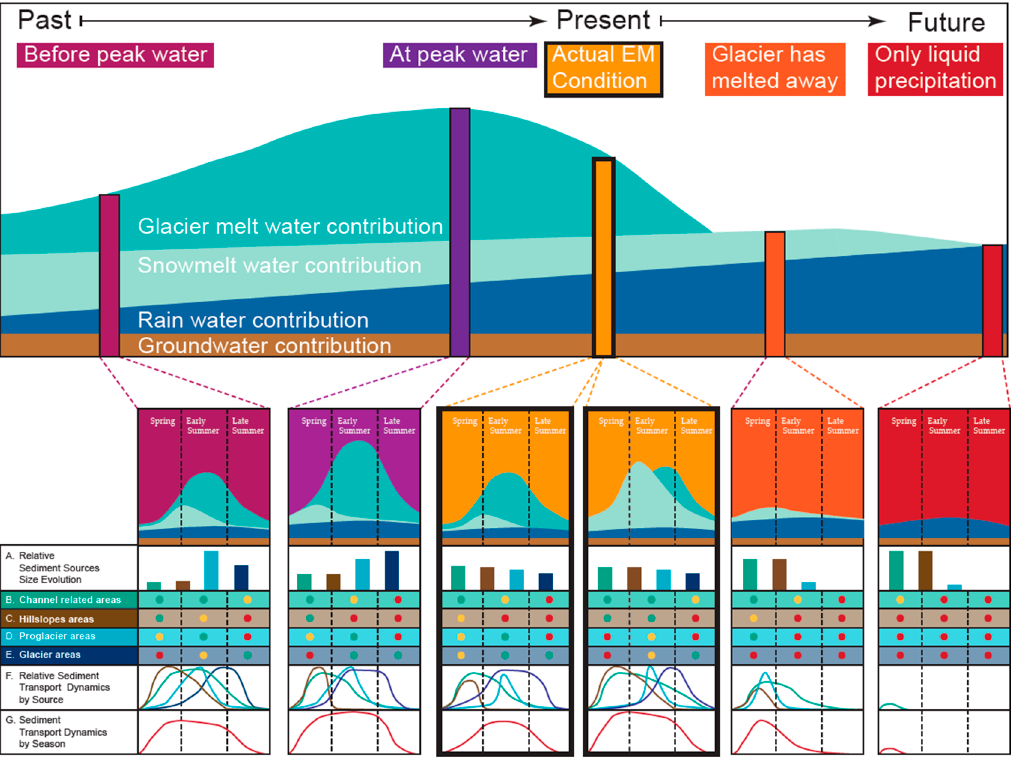
Figure 15. Conceptual representation of the coupling degree for in-channel, hillslopes, proglacial, and glacier sediment sources in the Estero Morales considering the following stages: (i) before the peak of water discharge, (ii) at the peak of water discharge, (iii) the actual conditions, (iv) after the peak of water discharge when glaciers have melted away, (v) future scenario of reduced solid precipitation (only rainfall). There are three phases—spring, early summer, and late summer—for each ablation-season-stage example. The colors green, yellow, and red represent well-coupled, midcoupled, and uncoupled conditions, respectively. This figure is inspired from Figure 1 in [44].